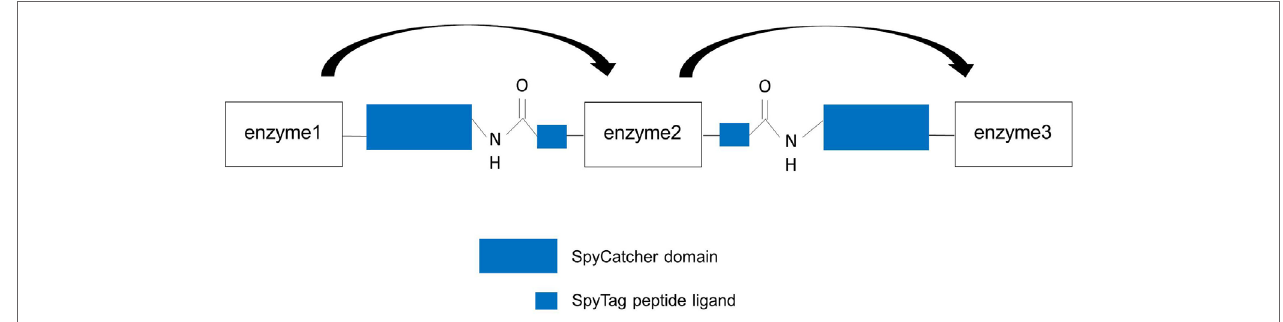
FiGURe 6 | Design of artificial trimeric proteins (functional trimer or even oligomers) by using the covalent SpySystem . By mixing SpyCatcher-, respectively, SpyTag-modified enzymes artificial, covalent enzyme pipes can be generated. Linker sequences between the enzymes and the Spy-domains should ensure correct protein folding and structure. Metabolic channeling between the single, covalently linked enzymes (indicated by the arrows) should be